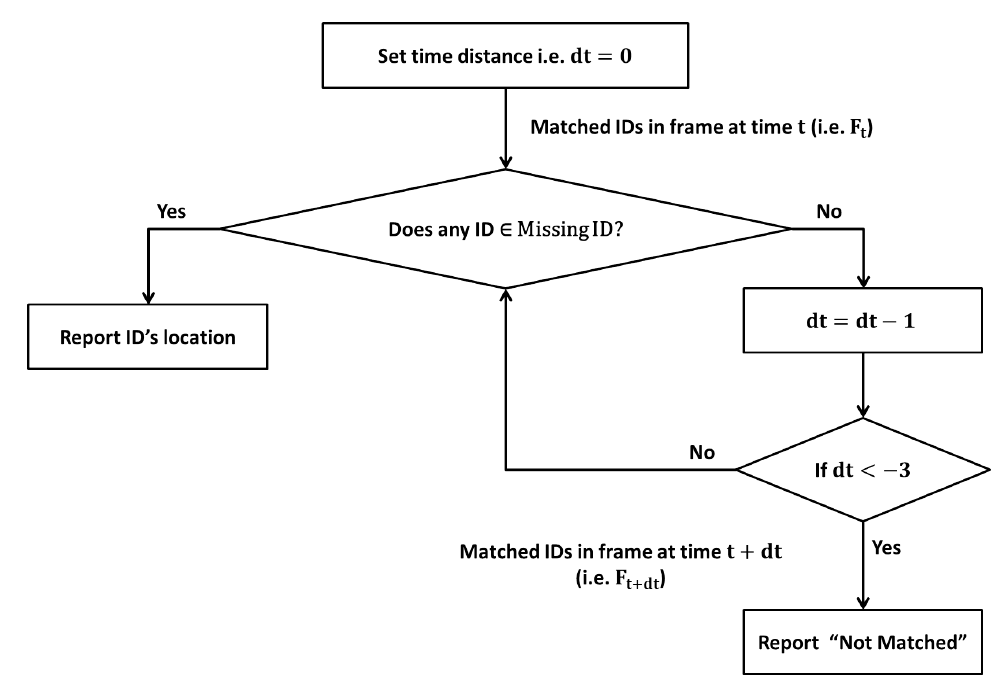
Figure 9. Smoothing operation to minimize irregularity of matched person presenc. The smoothed presence tracks of 12 personnel are presented in Figure 10, where false positive and the false negative presence of some of the 12 personnel can be seen easily.